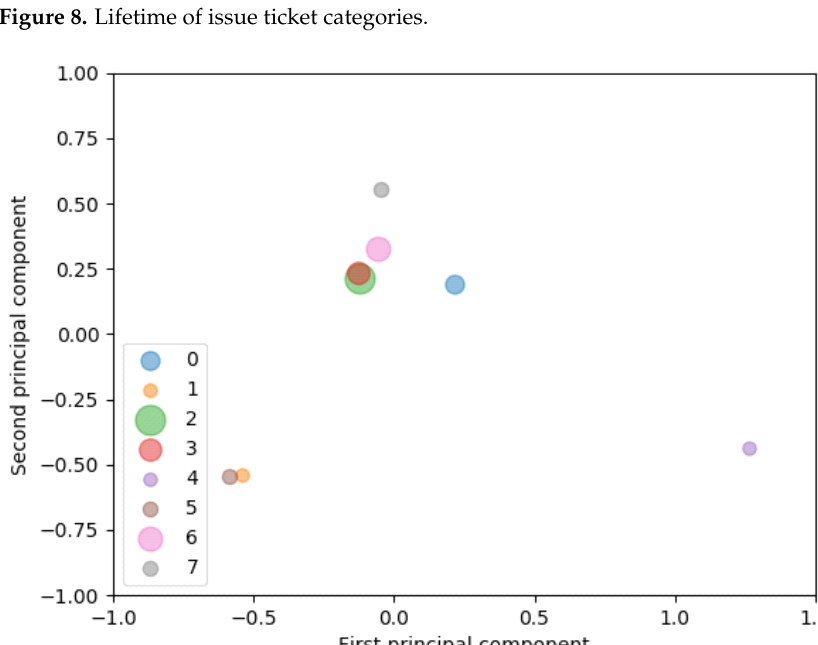
Figure 9. Relationships among issue ticket categories by